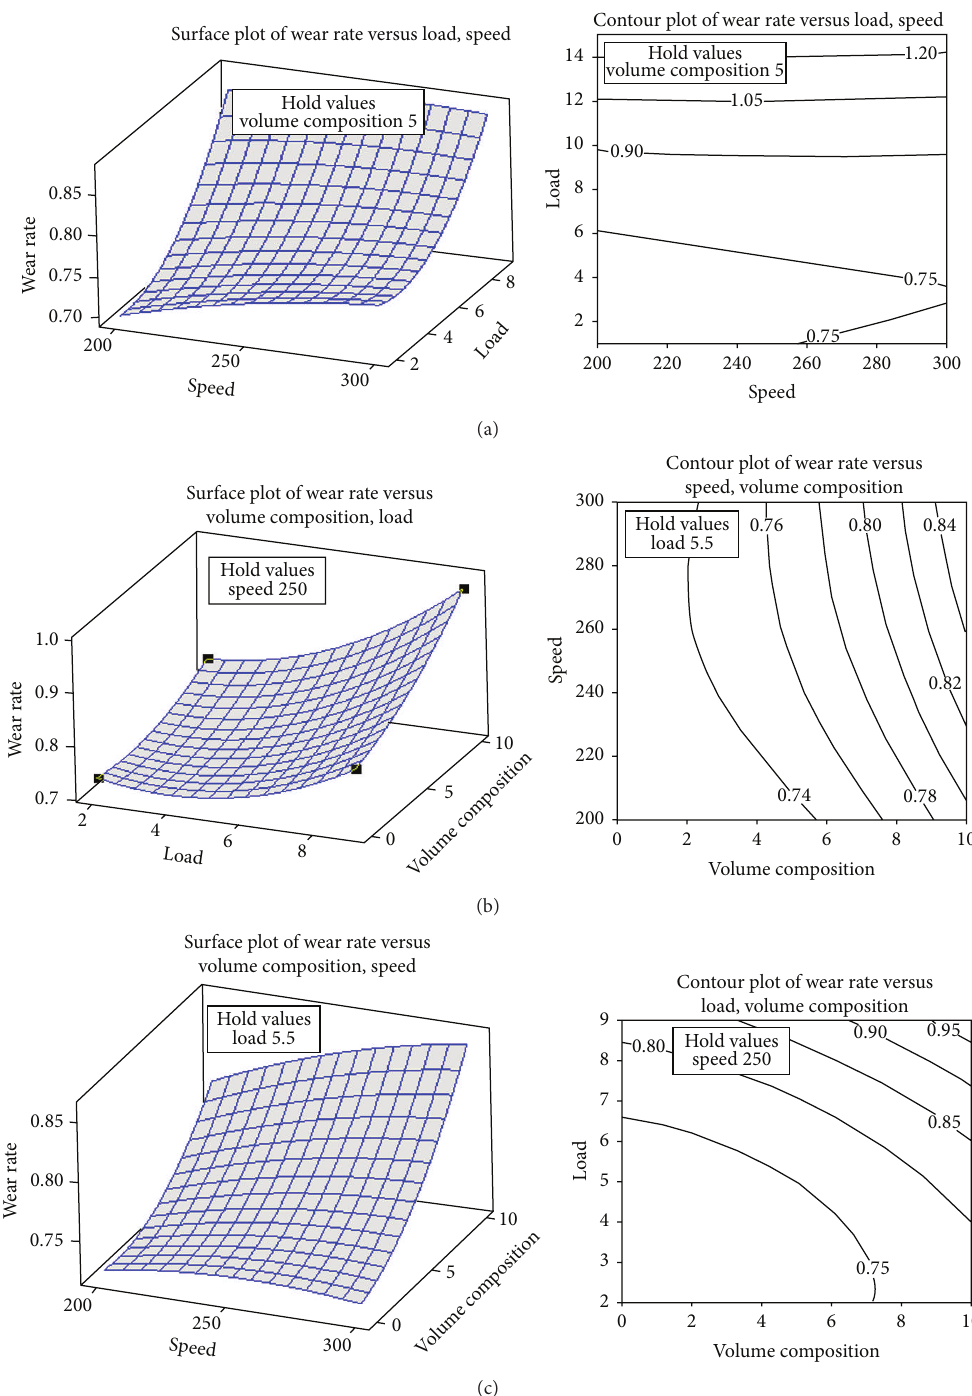
Figure 8: (a) Influence of load and speed on specific wear rate. (b) Influence of volume concentration and load on specific wear rate. (c) Influence of volume composition and speed on specific wear